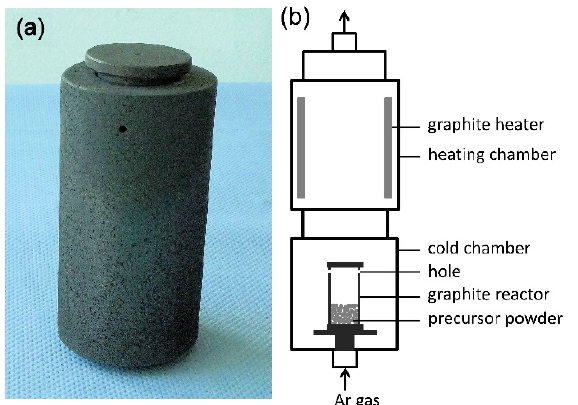
Figure 1. ( a ) Graphite cylinder reactor and ( b ) schematic illustration of a chamber furnace system for the synthesis of boron carbide powders.